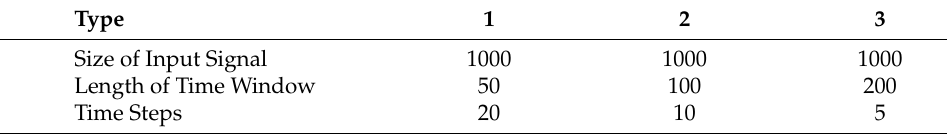
Table 4. Setting of CNN Time Window Parameters.